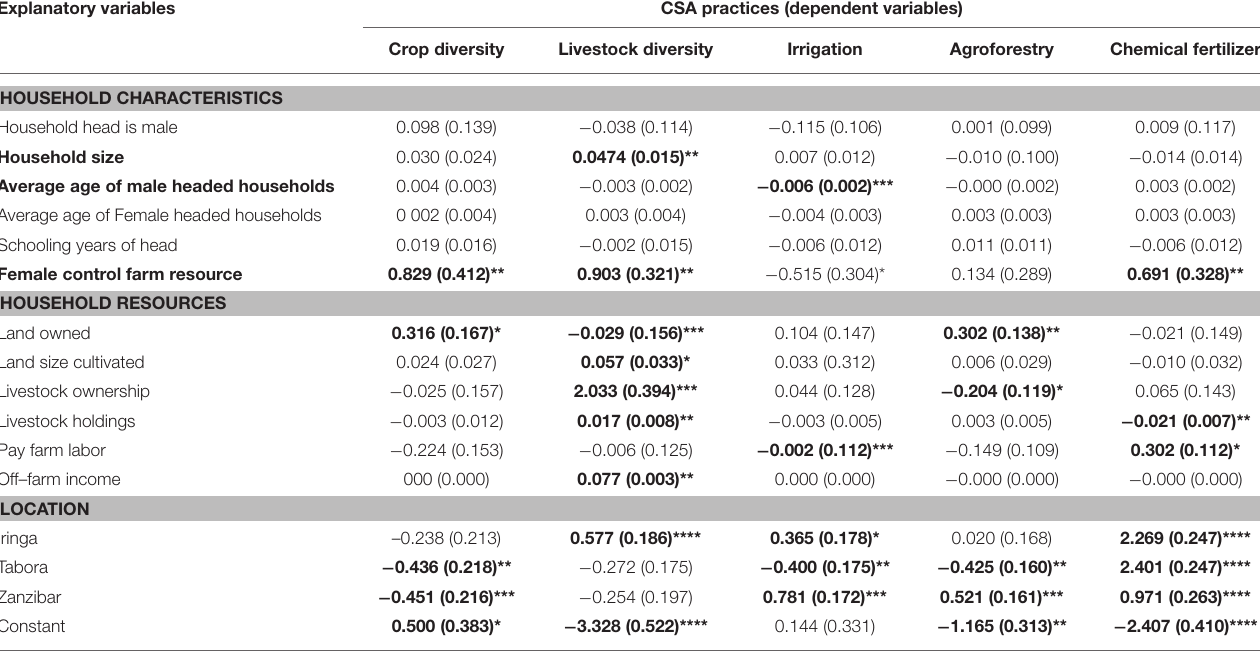
TABLE 5 | Coefficient estimates of the multivariate probit model (standard errors in